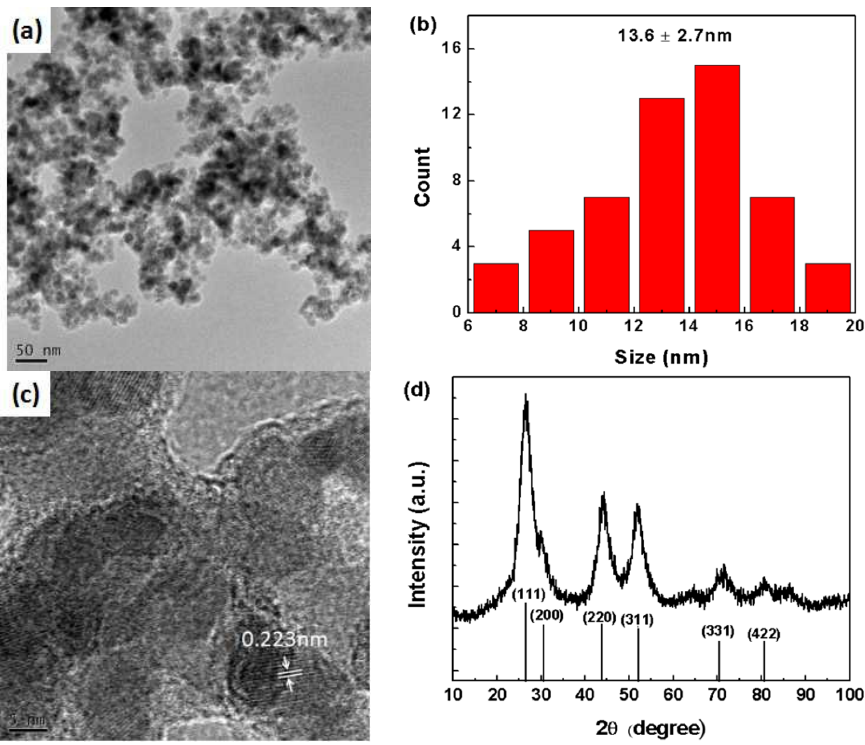
Figure 3. ( a ) TEM image, ( b ) particle size distribution, and ( c ) HRTEM image of the CdS NCs; ( d ) the XRD pattern of the CdS NCs.